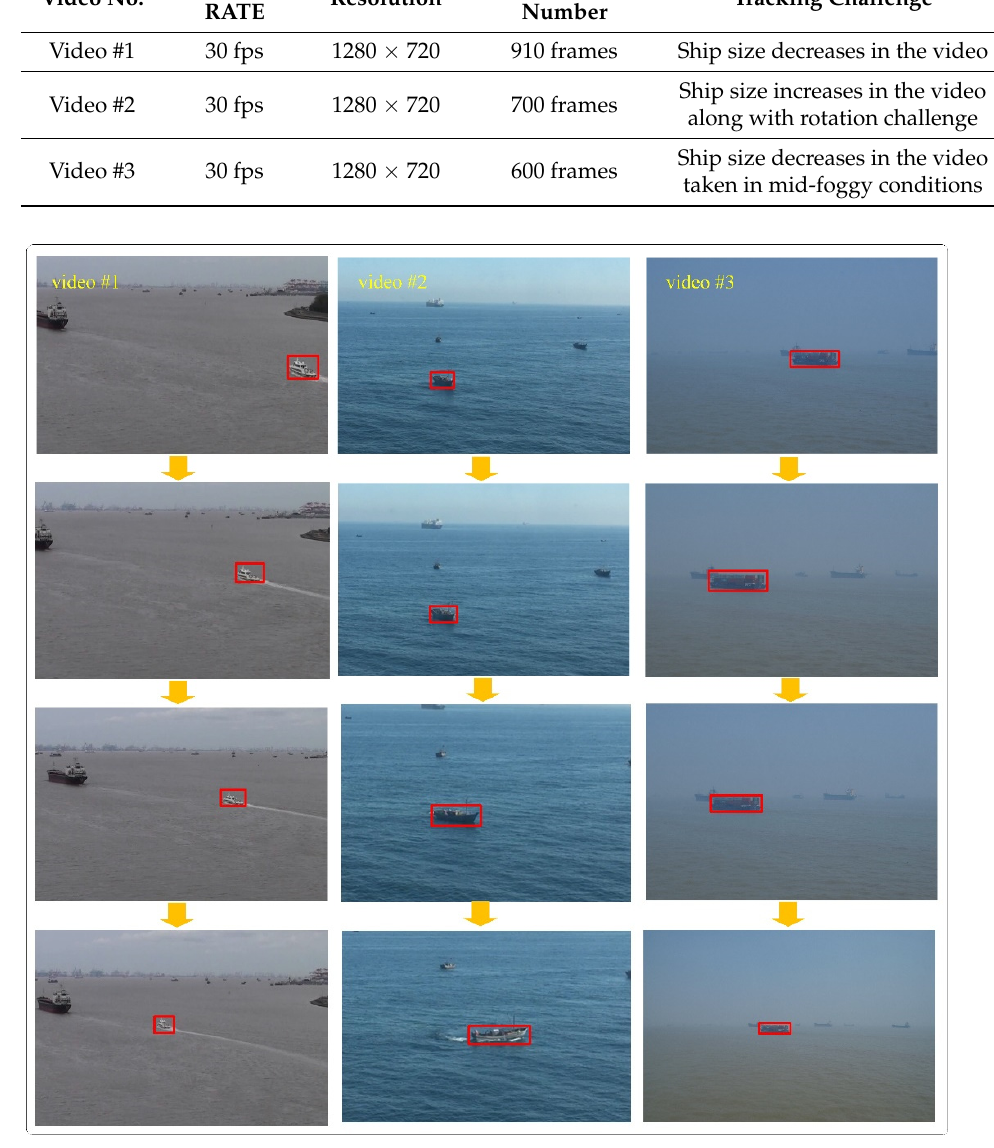
Figure 5. Ship frame samples (note that the red rectangle in each frame is the target